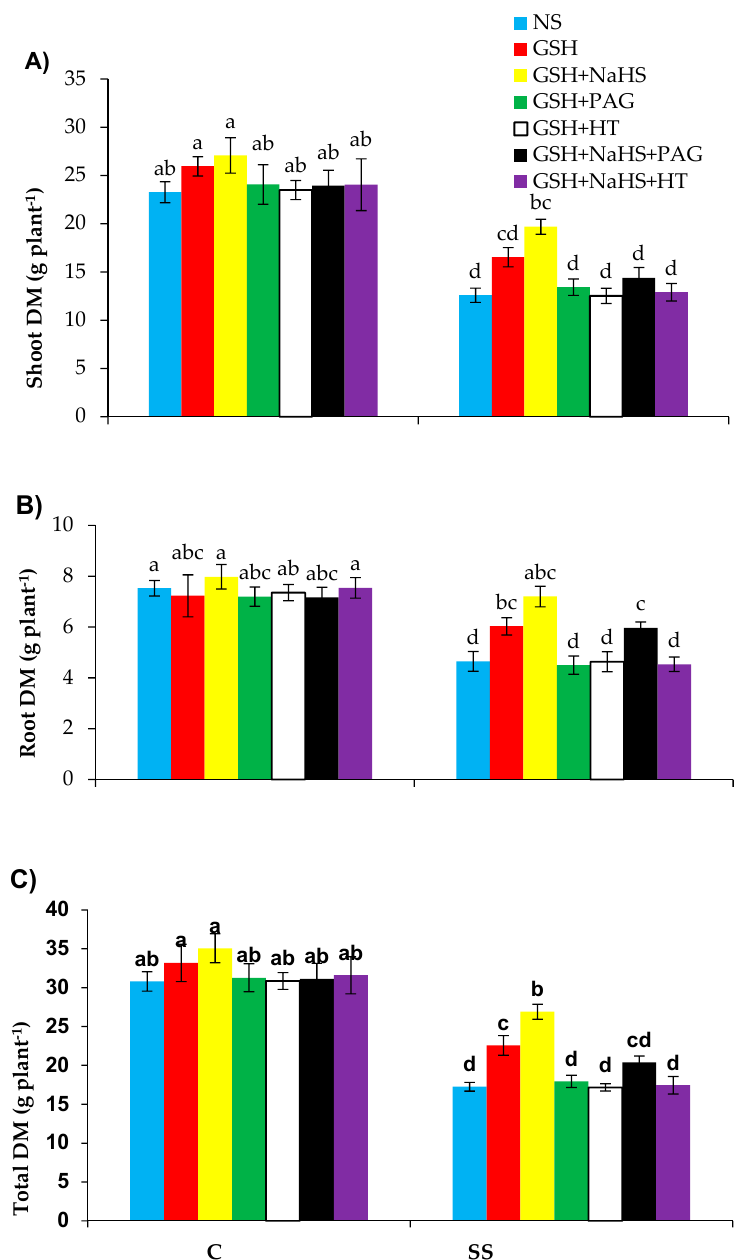
Figure 2. Shoot ( A ), root ( B ), total ( C ), and dry matter (DM) in pepper plants grown under control (C) and salinity stress (SS 100 mmol L − 1 NaCl), sprayed with glutathione (1.0 mmol L − 1 GSH) or sodium hydrosulfide (0.2 mmol L − 1 NaHS) alone or together, combined with a 0.1 mmol L − 1 scavenger of H 2 S, hypotaurine (0.1 mmol L − 1 HT), or inhibitor of l -DES, dl -propargylglycine (0.3 mmol L − 1 PAG). (Mean ± SE). Mean values carrying different letters within each parameter differ significantly ( p ≤ 0.001) based on Duncan’s multiple range test.